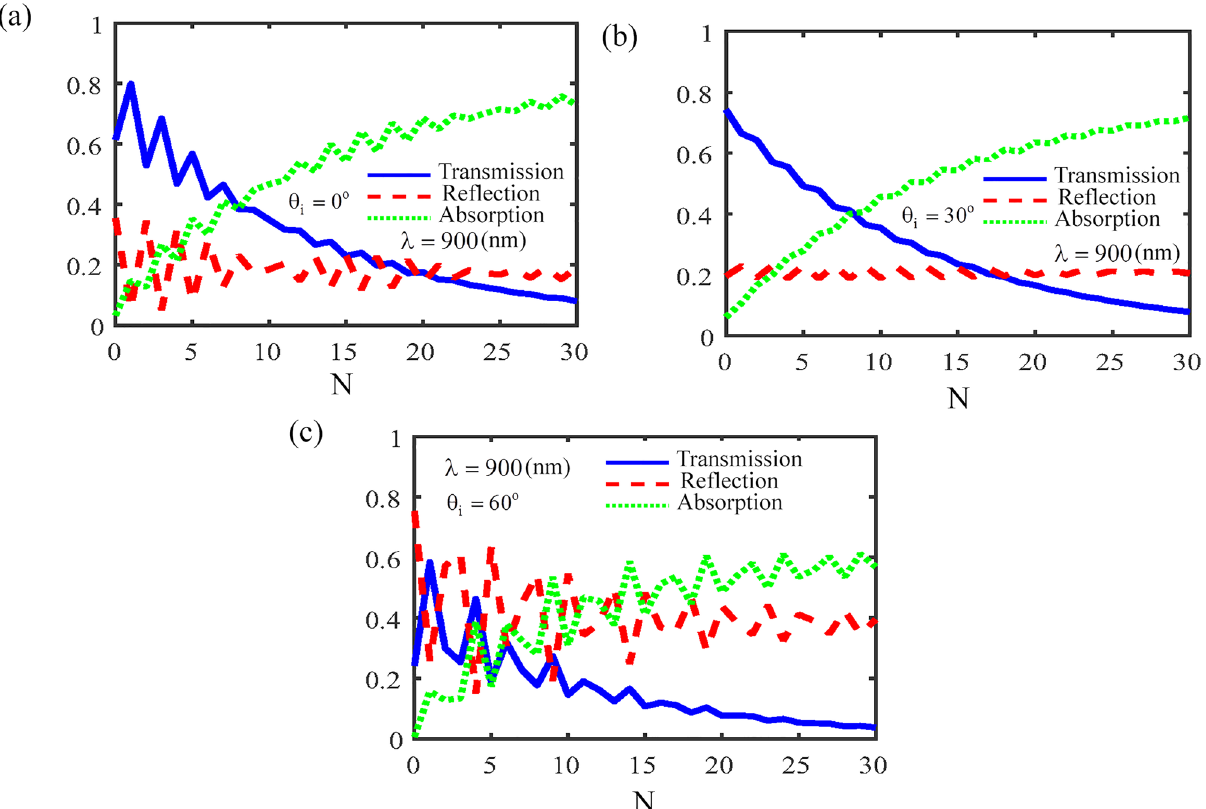
Figure 6. Absorbance, transmittance and reflectance coefficients as a function of the number of periods for different incident light angles for (cid:31) = 900 nm . ( a ) for θ i = 0